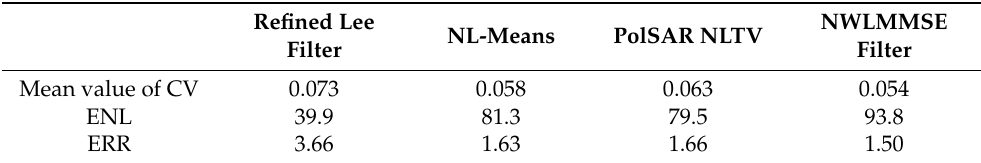
Table 1. Performance comparison for the different methods.